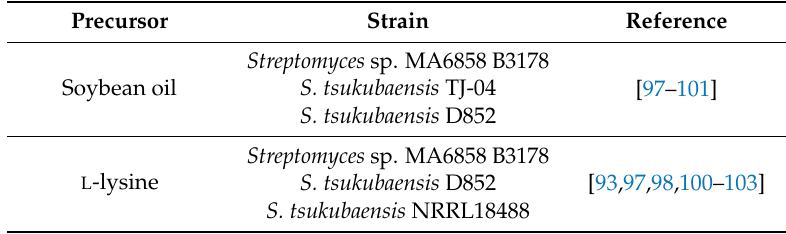
Table 1. Common precursors used for tacrolimus production enhancement in different S. tsukubaensis strains. The precursor, S. tsukubaensis strain used and bibliographic reference are